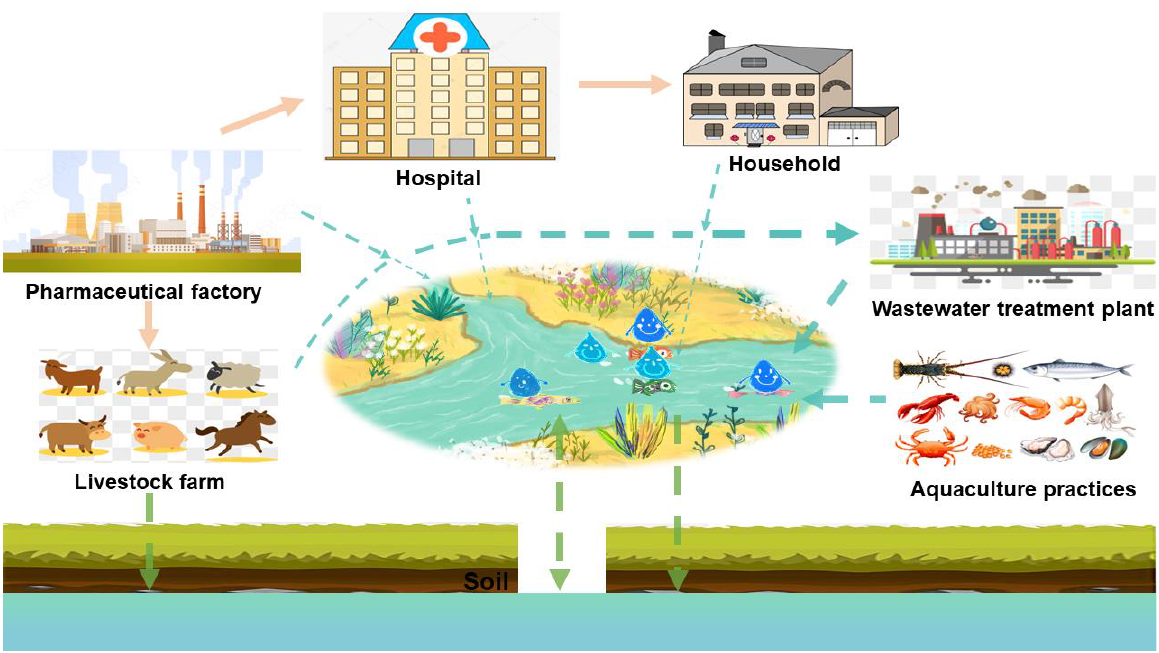
Figure 2. Sources of antibiotics in